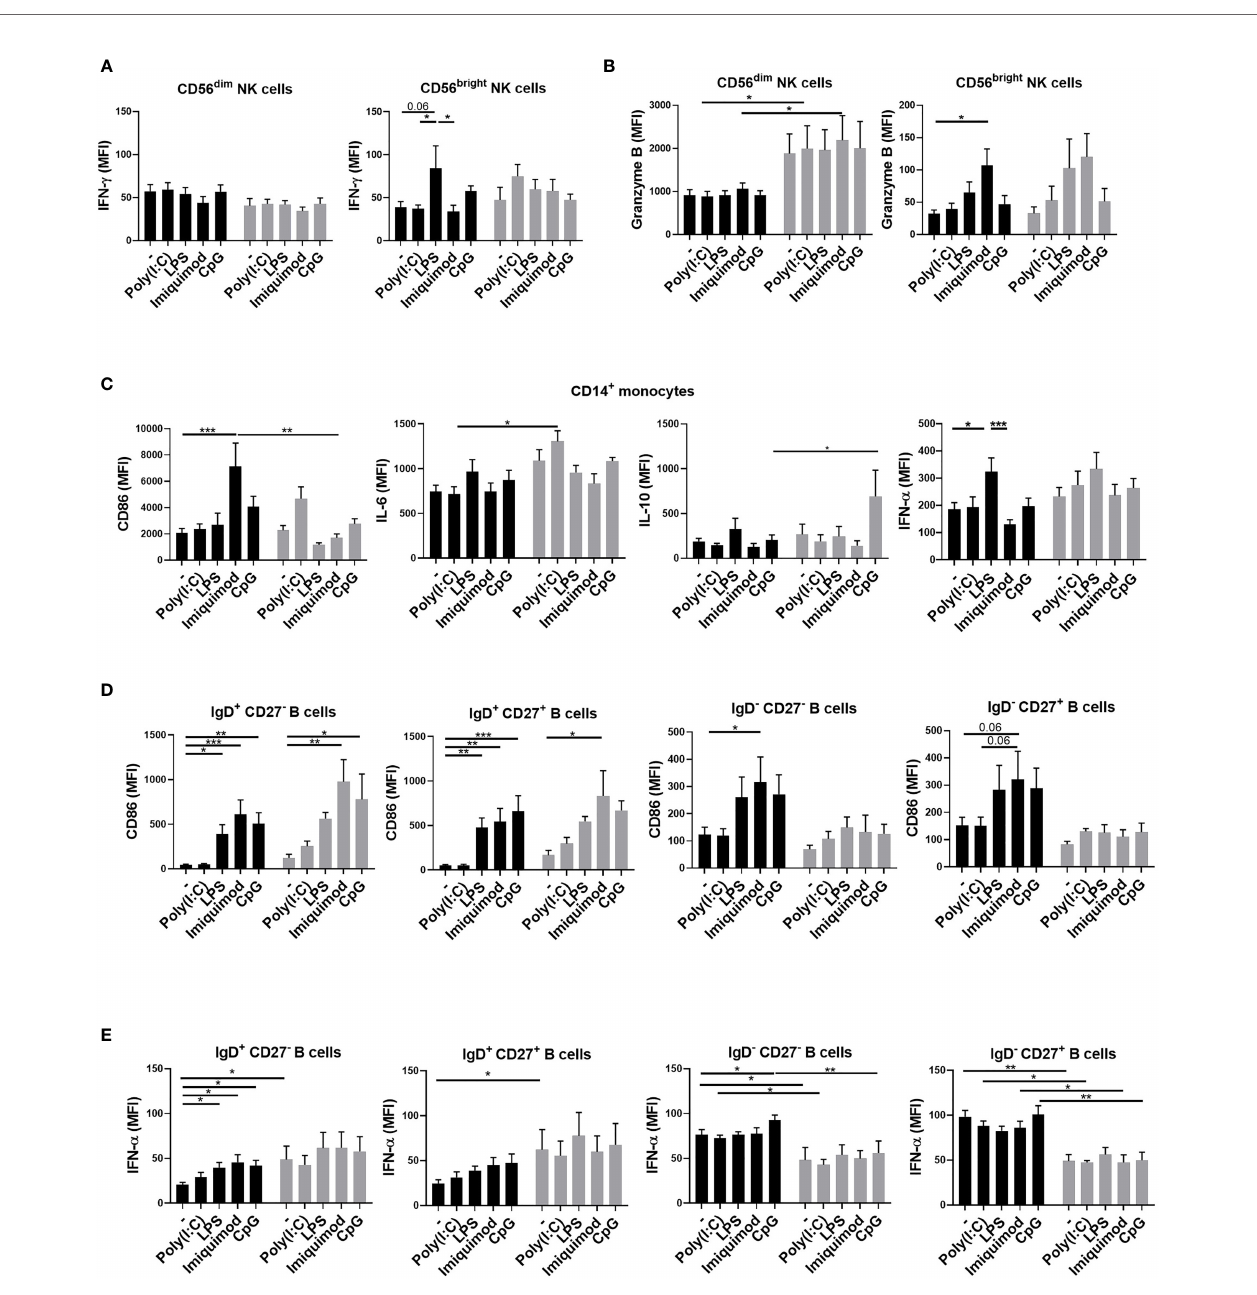
FIGURE 2 | Aberrant TLR-induced monocyte and B cell activation in the older adult subjects. PBMCs were isolated from young (black bars) and older adult subjects (gray bars) before vaccination. TLR-induced IFN- g (A) and granzyme B (B) expression in CD3 - CD56 dim or CD3 - CD56 bright NK cells; CD86, IL-6, IL-10, and IFN- a in monocytes (C) ; CD86 (D) and IFN- a (E) in B cells of the young and older adult vaccinees were detected after 3 days of stimulation. Statistical signi fi cance was determined using ANOVA with Tukey ’ s multiple-comparisons testing between all groups. (Black: young vaccinees; Grey: older adult vaccinees) (* p value < 0.05; ** p value <0.01; *** p value <